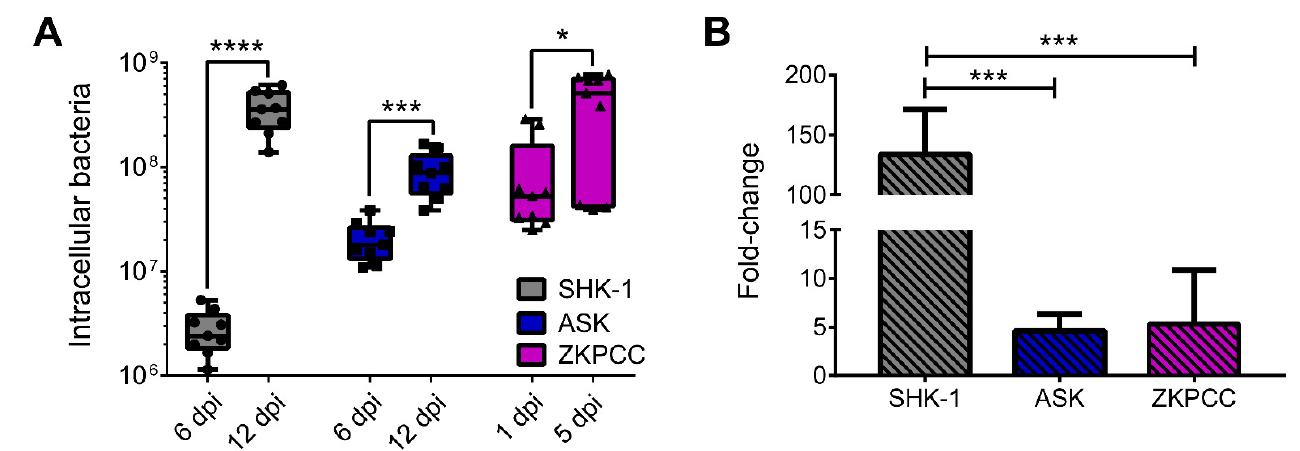
Figure 4. P. salmonis quantification inside infected cell cultures. The expression of bacterial housekeeping genes recF and rho in salmon cell lines (SHK-1 and ASK) or primary cell cultures (ZKPCC) at early- and late-stage infections (6 and 12 dpi for cell lines, and 1 and 5 dpi for ZKPCC) was quantified. Total number of bacteria was inferred from a standard curve (number of bacteria vs. Ct). ( A ) Number of intracellular bacteria at early- and late-stage infections in the three cell cultures. An unpaired t-test between early- and late-infection stages was performed for each cell culture, asterisks show statistical differences (* p < 0.05, *** p < 0.001 and **** p < 0.0001). ( B ) Fold-change of intracellular bacteria between early- and late-stage infections in the three cell cultures. A one-way ANOVA with Tukey’s multiple comparisons test was performed, asterisks show statistical differences (*** p <0.001).